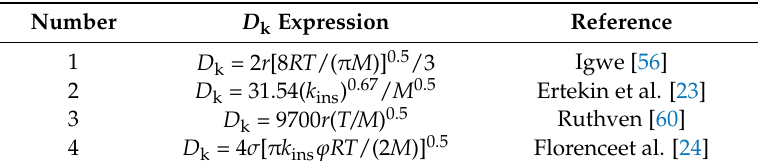
Table 2. Value of Knudsen diffusion coefficient in different